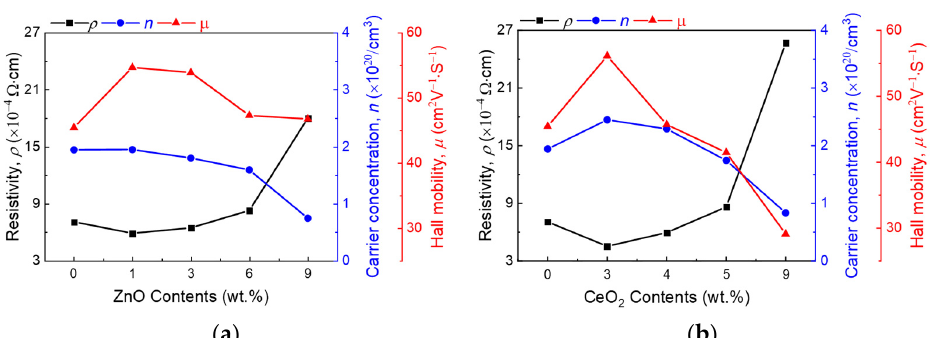
Figure 2. Comparison of electrical properties of ( a ) ZnO-doped ITO and ( b ) CeO 2 -doped ITO depending on the concentration of doping atoms. With a smaller amount of doping, the resistivities of both thin films decrease. On the other hand, excessive doping degrades the electrical properties of the thin film.